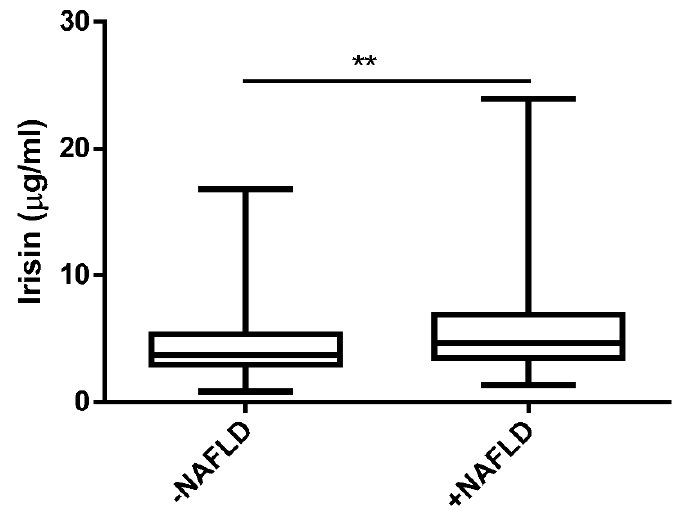
Figure 1. The serum level of irisin in patients without NAFLD ( − NAFLD; n = 66) and with NAFLD (+NAFLD; n = 72), measured by ELISA. The data are expressed as medians with lower and upper quartiles and minimal and maximal values. **, p < 0.01 − NAFLD group vs. +NAFLD group. Table 3. Spearman correlations and linear regression analysis of irisin concentration and anthropomet- ric and biochemical parameters in the whole study population ( n = 138). Only the best irisin-associated variables are shown, as assessed by the stepwise forward multiple regression